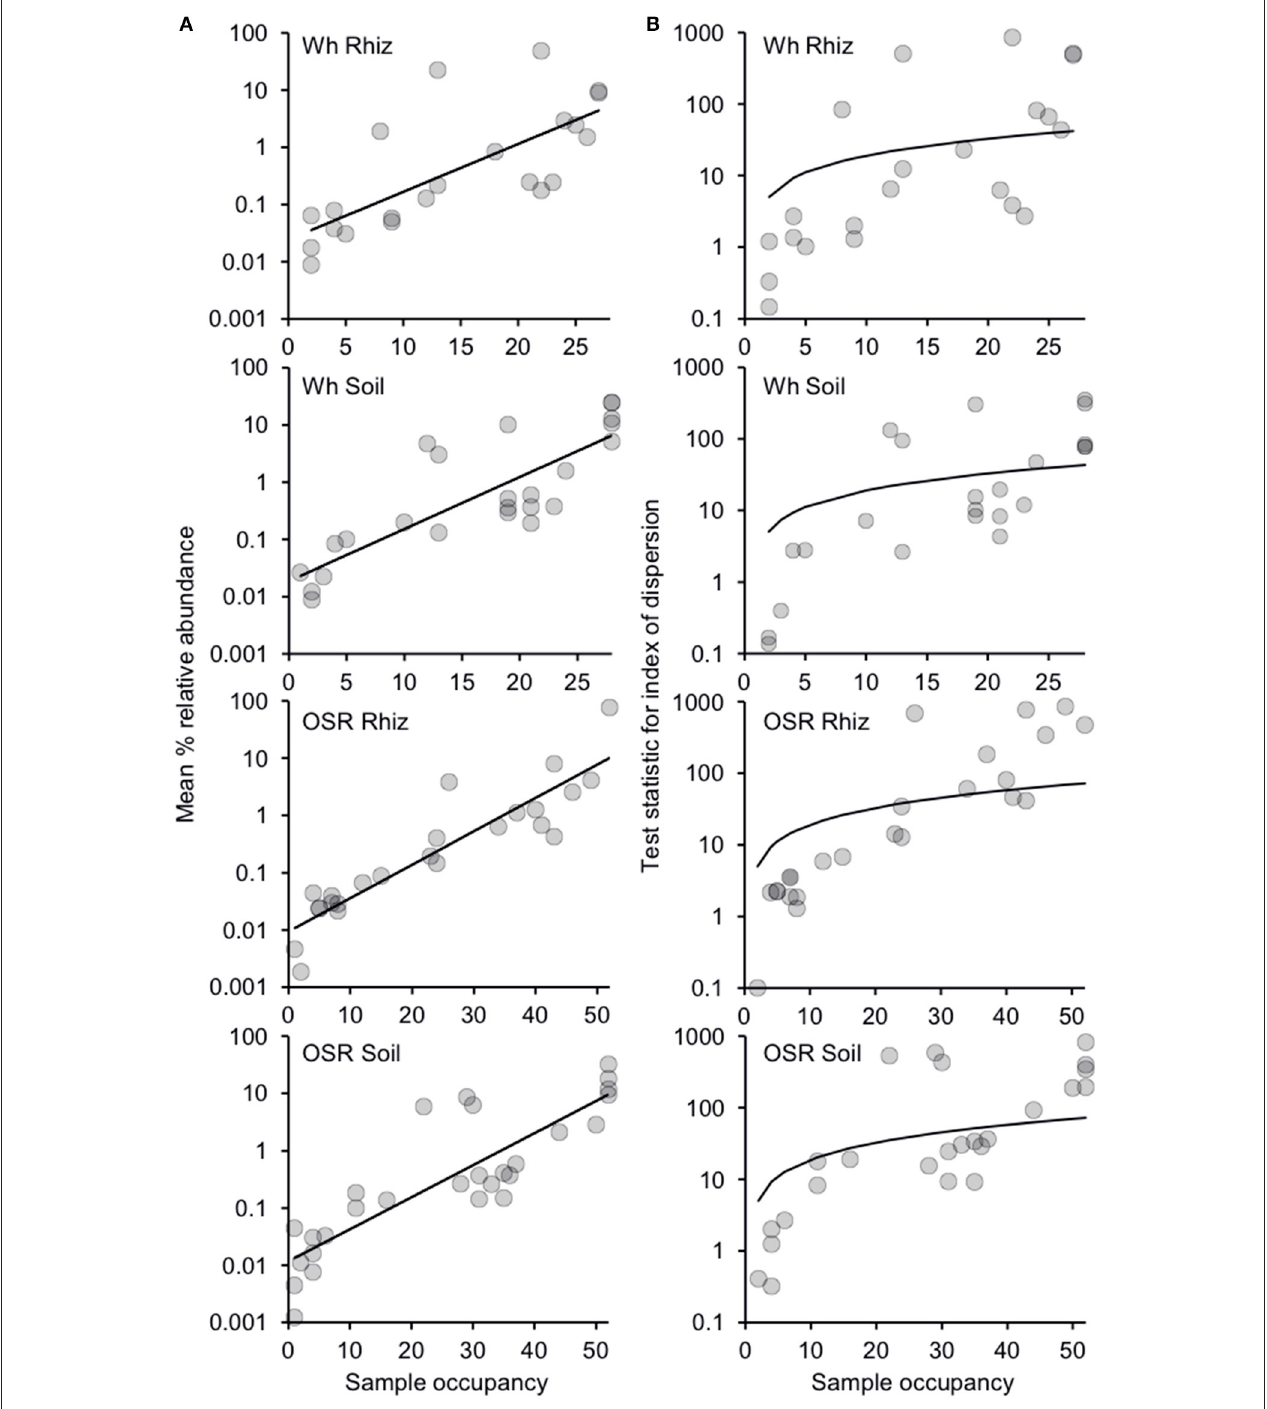
FIGURE 2 | Distribution and dispersal of plasmodiophorid OTUs among the rhizosphere and soil habitats. (A) Distribution-abundance relationships for each habitat, depicted as the number of samples for which each detected OTU was observed, plotted against the mean % relative sequence abundance (log 10 scale) of that OTU among all samples within each habitat (Wheat Rhizosphere, r 2 = 0.53, F (1,20) = 22.6, P < 0.0001; Wheat Soil r 2 = 0.68, F (1,22) = 47.4, P < 0.0001; Oil Seed Rape Rhizosphere, r 2 = 0.84, F (1,22) = 112.5, P < 0.0001; Oil Seed Rape Soil, r 2 = 0.74, F (1,26) = 75.1, P < 0.0001). (B) Random and non-random dispersal of plasmodiophorid OTUs through each habitat. Visualized by decomposing the overall distribution using an index of dispersion based on the ratio of variance to the mean abundance for each OTU. This is plotted against the number of samples for which the OTU was present in that community. The line depicts the 2.5% confidence limit for the χ 2 distribution. Taxa that fall below this line follow a Poisson distribution, and are randomly distributed and are considered satellite taxa, whereas those that are above the line are non-randomly distributed and are considered core taxa. The 97.5% confidence limit was not plotted, as no taxon fell below that line.